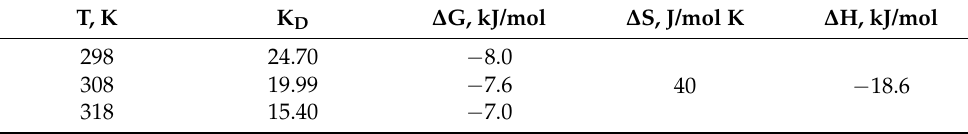
Table 4. Thermodynamic parameters of the adsorption of Pb(II) ions on